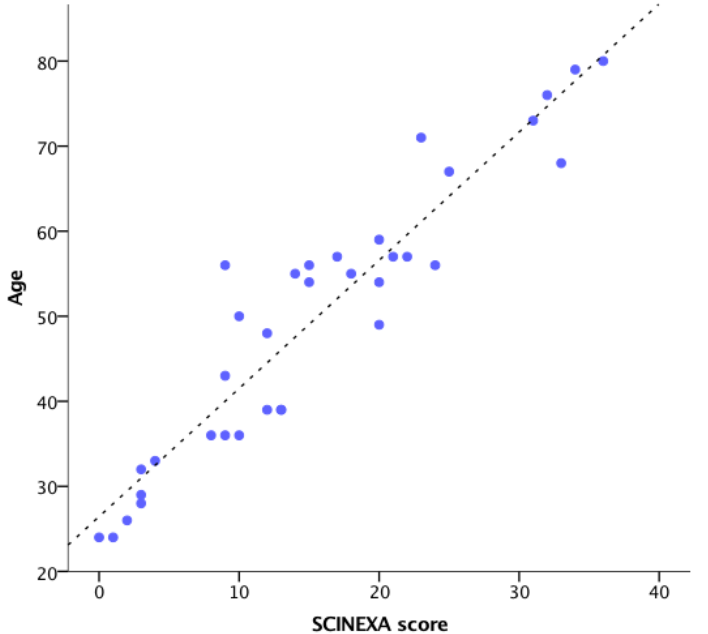
Figure 1. Total SCINEXA score correlated with subject age in every case. When the intrinsic and extrinsic scores were considered separately, an ascending trend was observed among different age groups ( p < 0.01; Figure 2). However, the differ- ences were statistically significant only when comparing age group I with age groups IV and V and group II with group V.